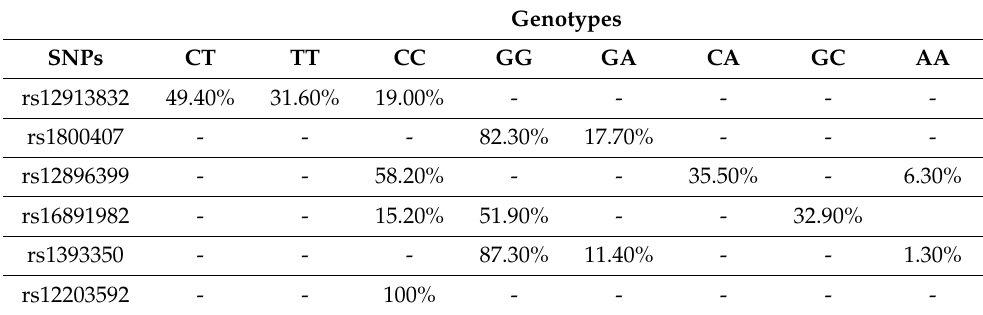
Table 3. Percentage of Irisplex SNPs present in Pakhtoon population.